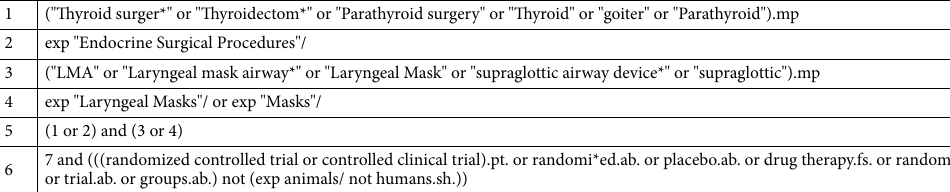
Table 1. Search strategies for